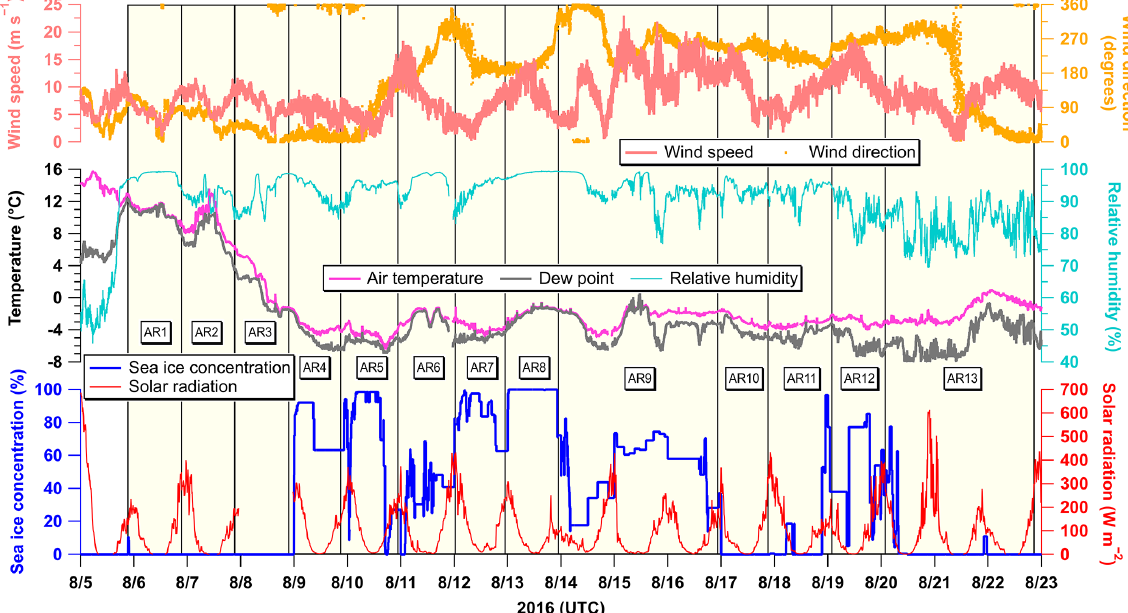
Figure 3. Temporal variations of meteorological variables, including wind speed (ms − 1 ), wind direction (degrees), air temperature ( ◦ C), dew point ( ◦ C), relative humidity (%), solar radiation (Wm − 2 ), and sea ice concentration (%) along the ship’s track during the cruise. The hatched yellow area indicates the sampling duration of each aerosol sample (AR1–AR13). Solar radiation was not recorded from 23:20UTC on 7 August to 23:10UTC on 8 August due to equipment malfunction. Sea ice concentration represents the percentage of an area covered with sea ice at the ship’s location within a 3.125km × 3.125km grid derived from AMSR 2 sea ice concentration daily data (Spreen et al.,